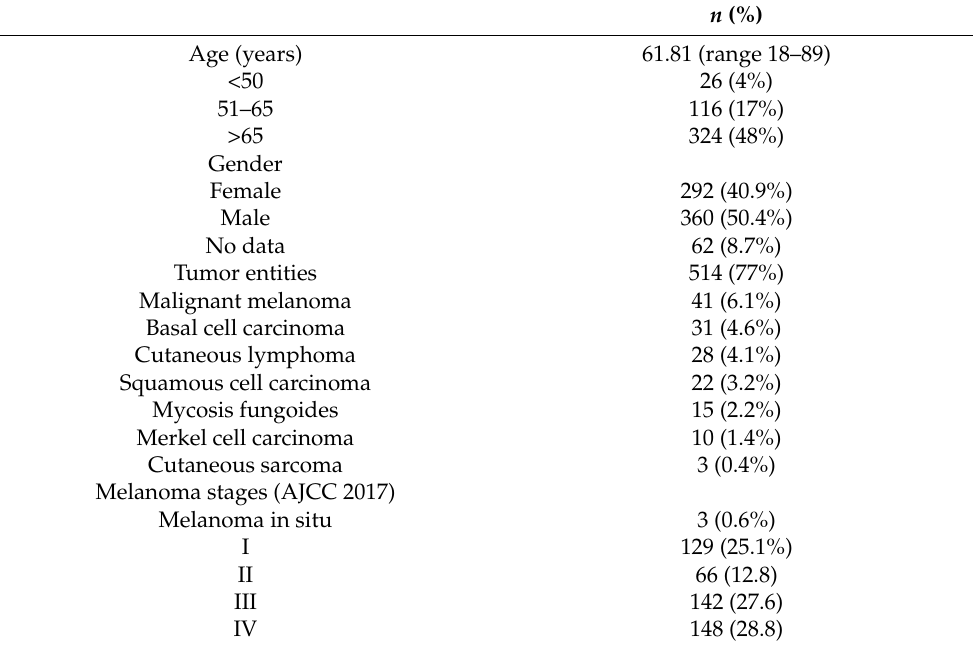
Table 1. Baseline characteristics of